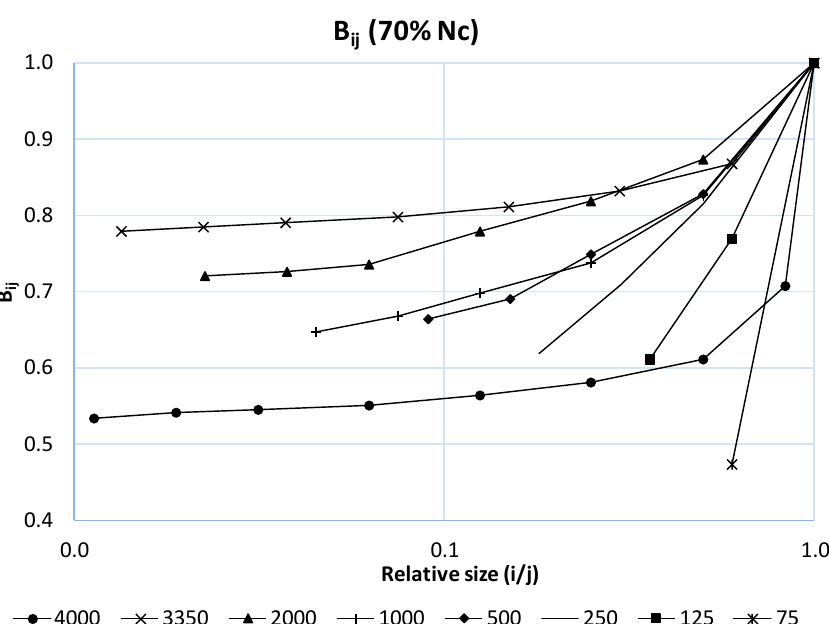
Figure 5. Behavior of the fracture function ( B ij ), with respect to particle size. 70% working speed Nc (Barruecopardo ore).